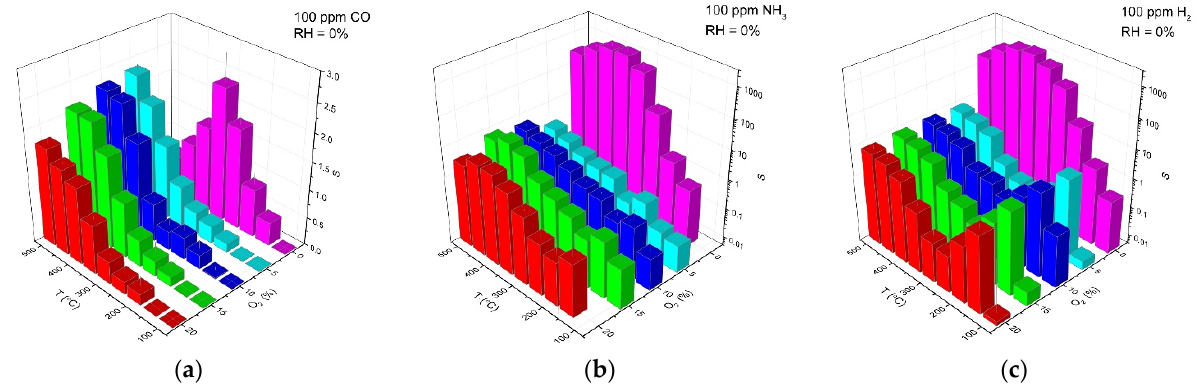
Figure 4. Temperature dependences of sensor response of ZnO/Pd nanofibers to 100 ppm of reduc- ing gases CO ( a ), NH 3 ( b ) and H 2 ( c ) in dry atmosphere (RH = 0%) with different oxygen back- grounds C(O 2 ) = 20, 15, 10, 5 and 0.0005%.